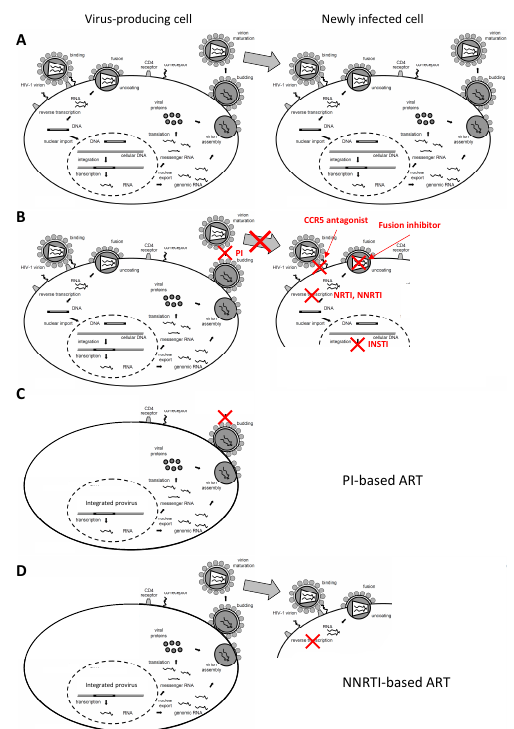
Figure 1. HIV replication cycle and the e ff ects of antiretroviral drugs. ( A ) Untreated infection. After the virus particle attaches to receptors on the cell surface, the HIV RNA genome enters the cytoplasm and is reverse-transcribed into DNA, which is transported to the nucleus where it integrates into the host cell genome and serves as a template for viral transcription. Transcription of the proviral DNA template and alternative RNA splicing creates spliced and unspliced viral RNA species, encoding the viral structural and accessory proteins. All viral transcripts are exported into the cytoplasm, where translation and assembly and processing of the retroviral particle take place. The cycle is completed by the budding of retroviral particles from the cell and their maturation that produces infectious virions, which can infect new cells. ( B ) Di ff erent classes of antiretroviral drugs, such as protease inhibitors (PIs), CCR5 antagonists, fusion inhibitors, nucleoside and non-nucleoside reverse transcriptase inhibitors (NRTIs and NNRTIs), and integrase strand transfer inhibitors (INSTIs), prevent infection of new cells by blocking (depicted with red X) di ff erent stages of the HIV replication cycle. Although these regimens act at di ff erent stages of the viral replication cycle, neither of them inhibits HIV RNA transcription or virus production in long-lived reservoir cells that were infected prior to ART initiation or the progeny of such cells. However, the infection of new cells is prevented. Note that most reservoir cells in individuals on ART do not produce virus at any given time, but can be reactivated to do so in response to immune stimuli. Note also that PIs do not prevent virus production but block virion maturation, rendering virus particles noninfectious. In NNRTI- and INSTI-treated individuals, virus particles are infectious and can enter new cells, but the infection is blocked at the stage of reverse transcription or DNA integration, respectively. ( C ) PI-based ART. ( D ) NNRTI-based